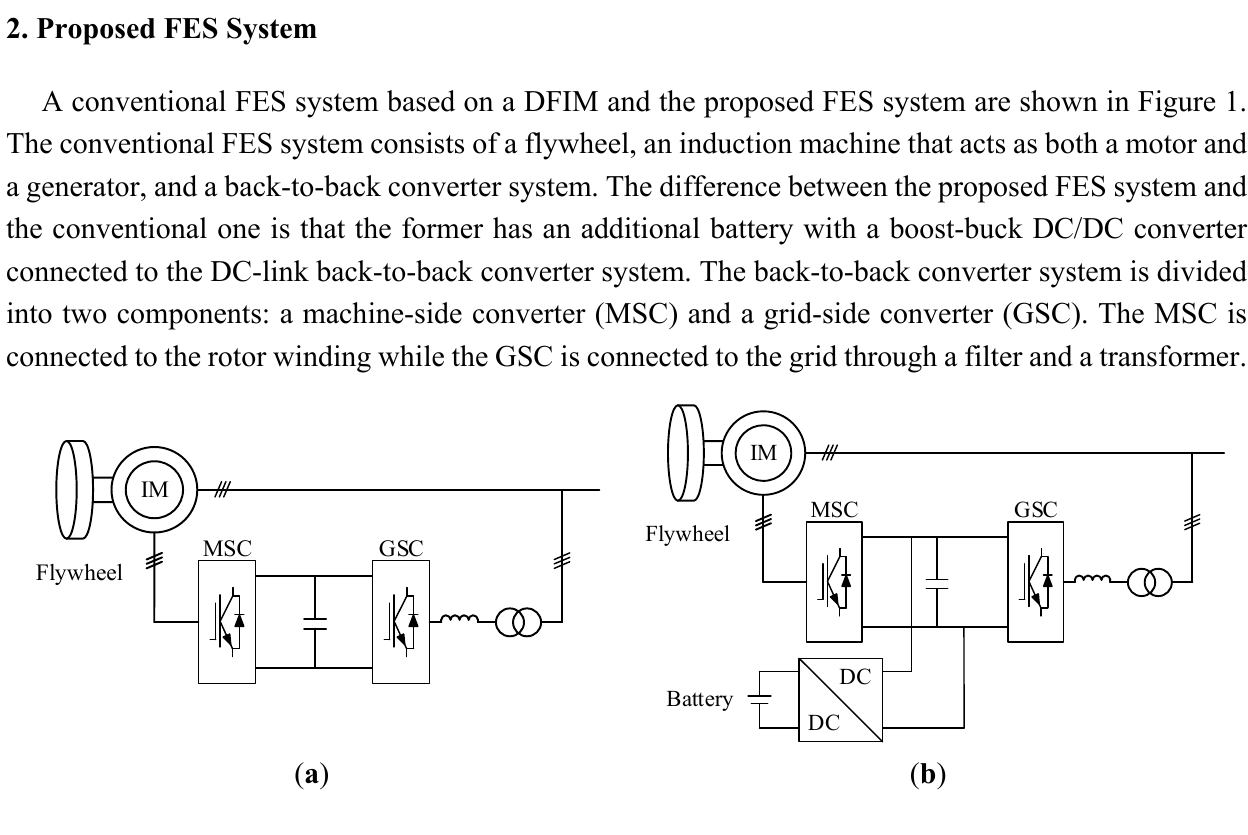
Figure 1. FES systems: ( a ) conventional FES system; ( b ) proposed FES